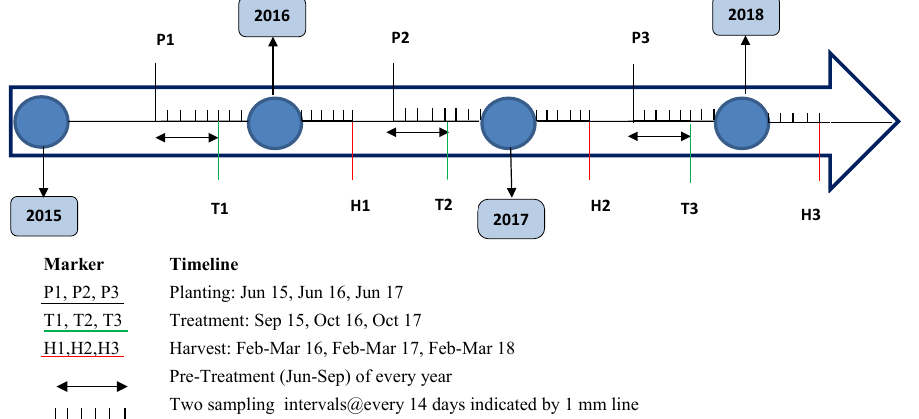
Fig. 1: Timeline chart for the field trial conducted in the turmeric